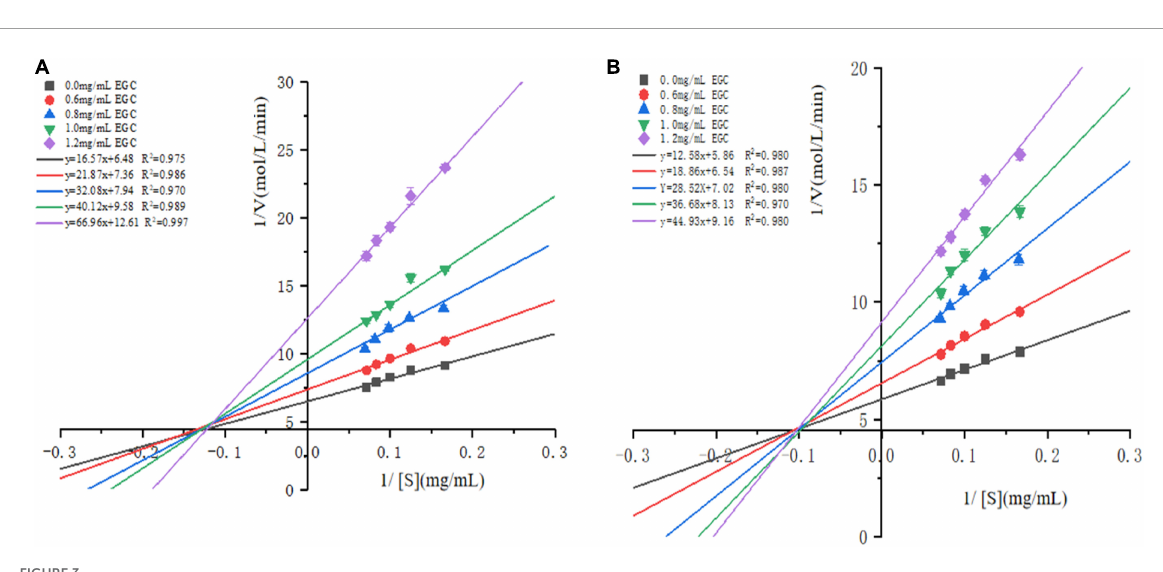
FIGURE3 Lineweaver–Burk plots for inhibition of α -glucosidase and α -amylase by epigallocatechin with different